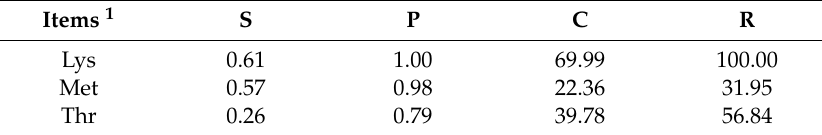
Figure 3. The pattern diagram ( b ) when Met and Thr are converted to an equivalent slope ( a ) with Lys. The y-axis represents the ratio of NR after deleting Lys, Met, Thr to that of the PC treatment; the x-axis is the ratio of the amino acid intake (AAI) in the amino acid deleting treatments to that in the PC treatment. (Lys, ■ ) = Lys intake and NR level in PD – Lys treatment, (Met, ▲ ) = Met intake and NR level in PD – Met treatment, (Thr, ◆ ) = Met intake and NR level in PD – Thr treatment, and (PC, ●) = Lys, Met, Thr intake and NR level in PC treatment; all values =1. Table 6. The appropiate amino acid ratio of Lysine (Lys), Methionine (Met), and Threonine (Thr) based on the nitrogen retention (NR) of heifers aged seven to nine months old, fed corn–soybean meal-based